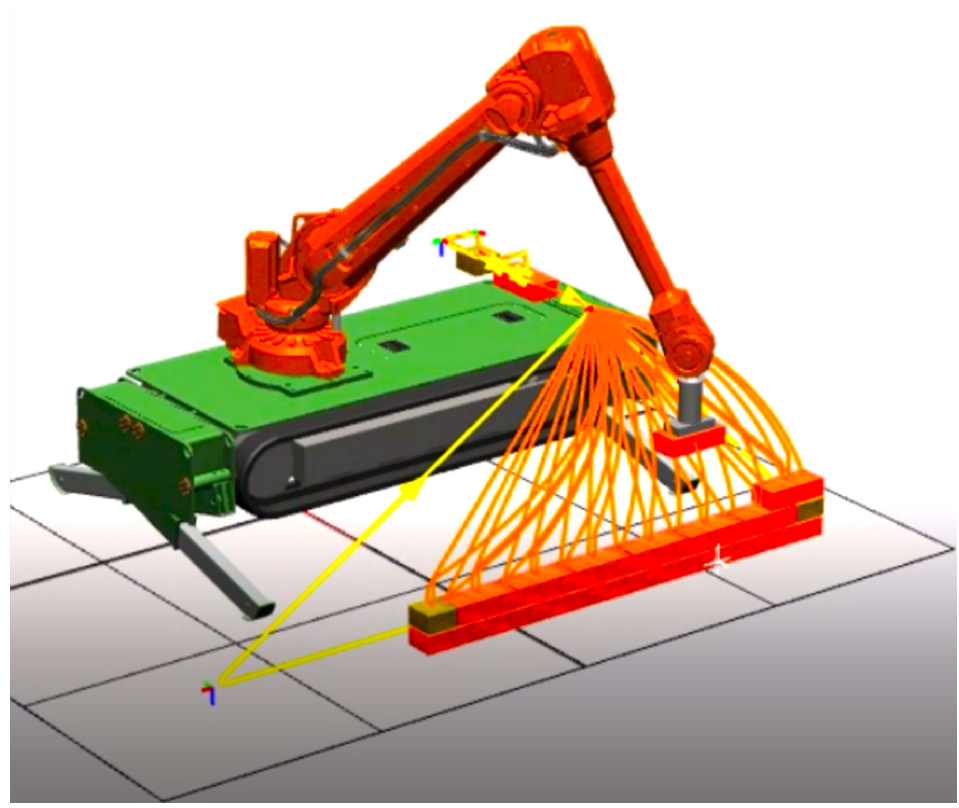
Figure 10. Visualize the robot’s trajectory during bricklaying in RobotStudio (ABB).